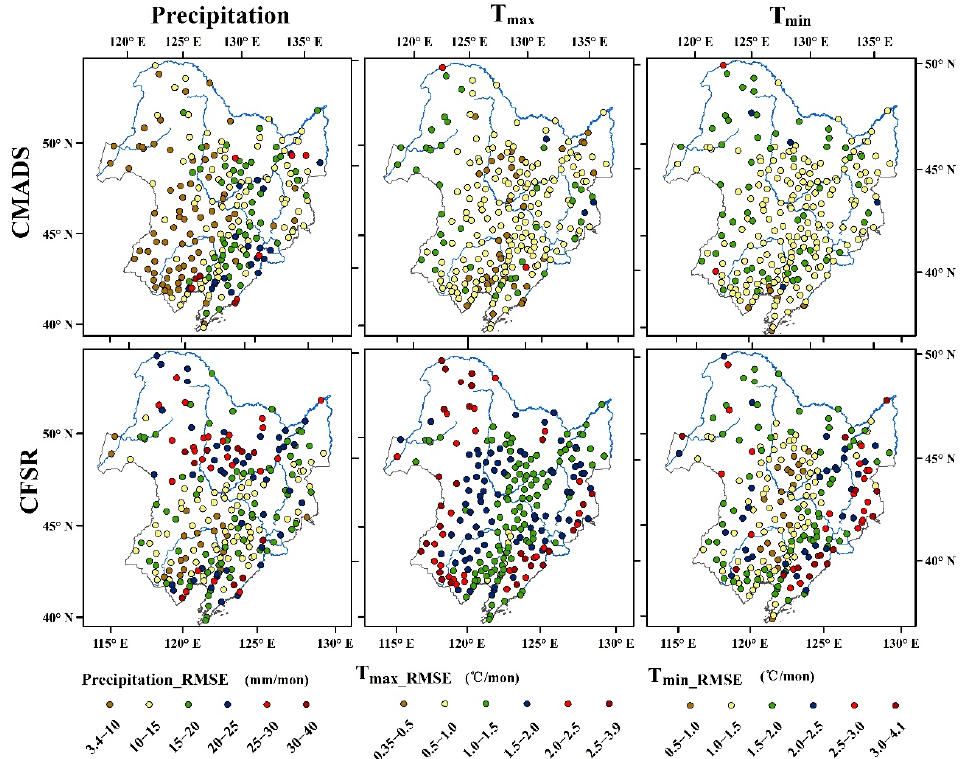
Figure 4. The spatial RMSE from the stations in NEC. Marks: The figures in the first and second lines show the spatial RMSE of the three meteorological elements (precipitation, maximum temperature, and minimum temperature) from CMADS and CFSR, respectively.